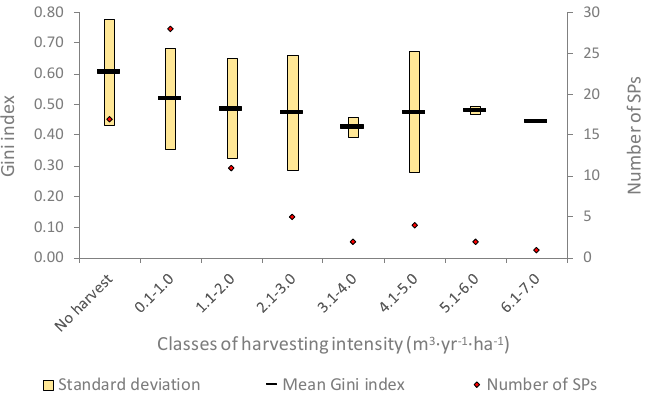
9 of 23 Figure 3. Forest structure diversity on forest management types (green color highlights the signifi-